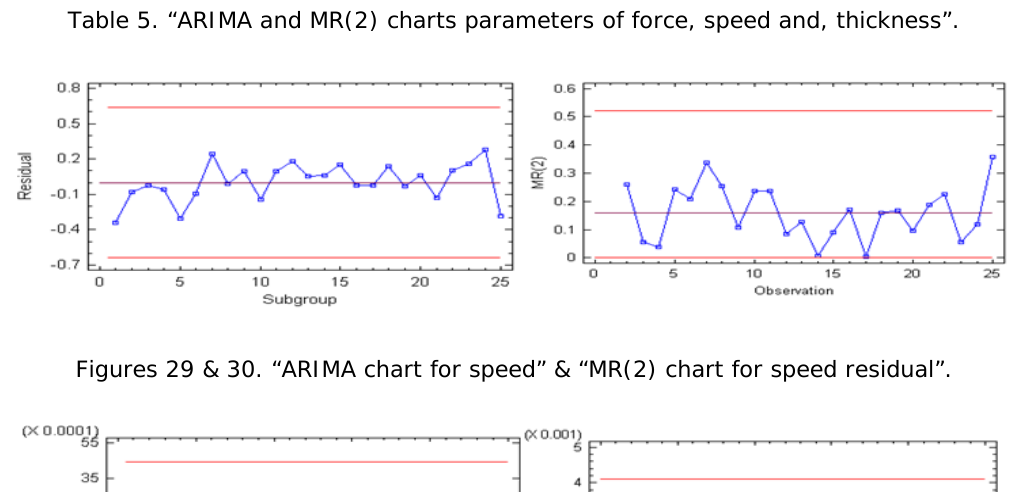
Table 5. “ARIMA and MR(2) charts parameters of force, speed and,